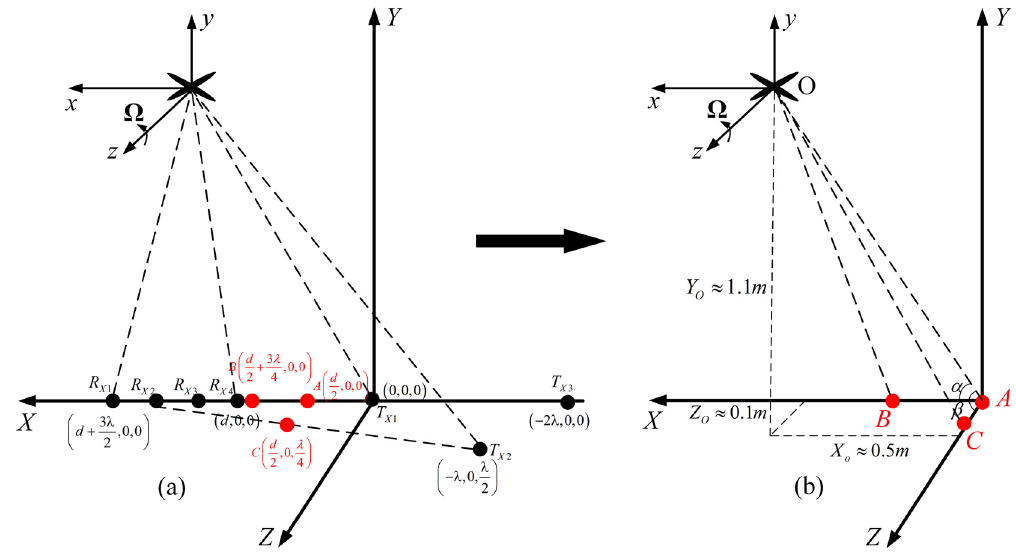
Figure 14. Experiment observation geometry: ( a ) real observation geometry; ( b ) equivalent observation geometry.